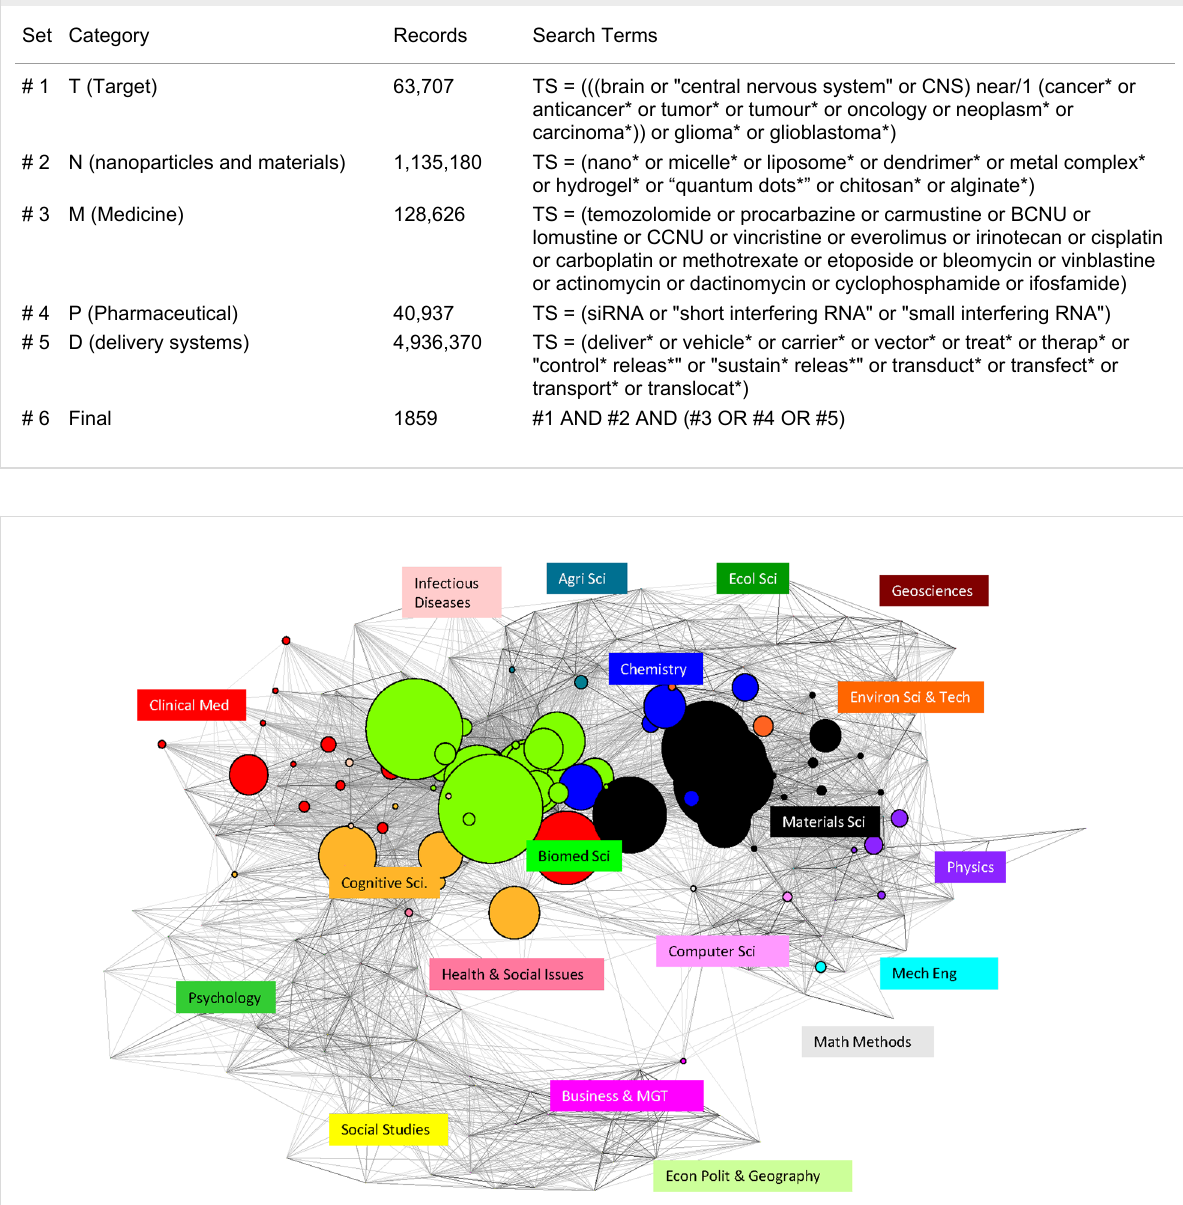
Table 1: Search Strategy of NEDD for Brain Cancer in Web of Science.